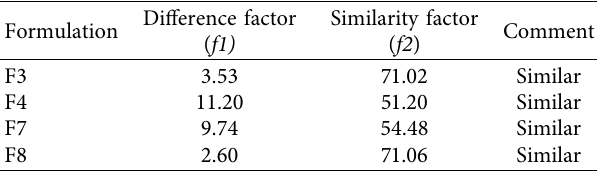
Table 6: Difference ( f1 ) and similarity ( f2 ) factors of formulated batches of Melia azedarach gum in comparison with standard binder (tragacanth) or disintegrant (starch).